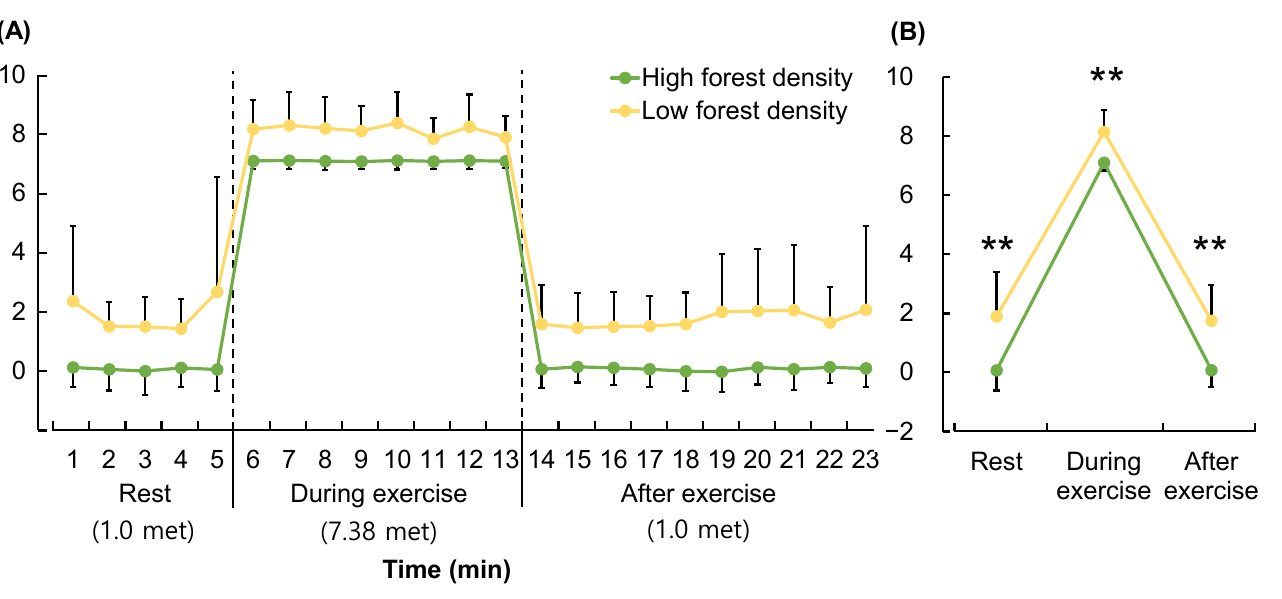
Figure 5. Changes in the predicted mean vote (PMV) between high forest density and low forest density. ( A ) Time-dependent changes in PMV N = 18, mean ± standard deviation. ( B ) Overall mean PMV in the “rest”, “during exercise”, and “after exercise” periods. N = 18, mean ± standard deviation; ** p < 0.01 using the independent t -test.